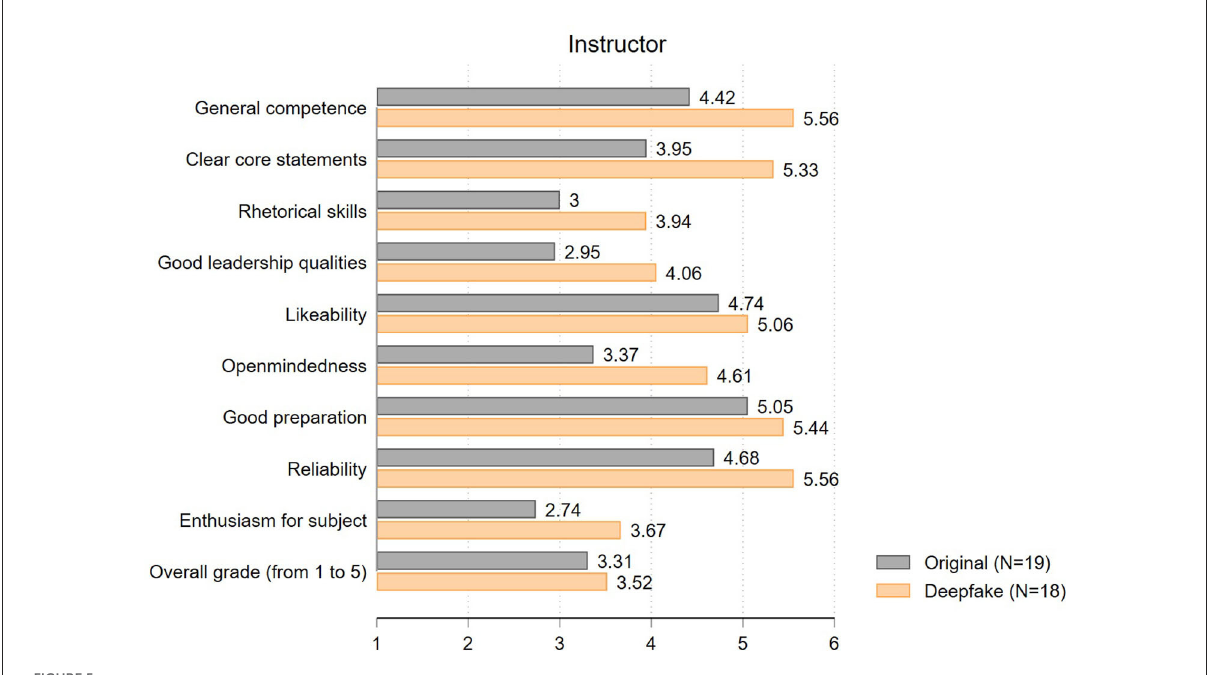
FIGURE5 Evaluation of instructor (mean